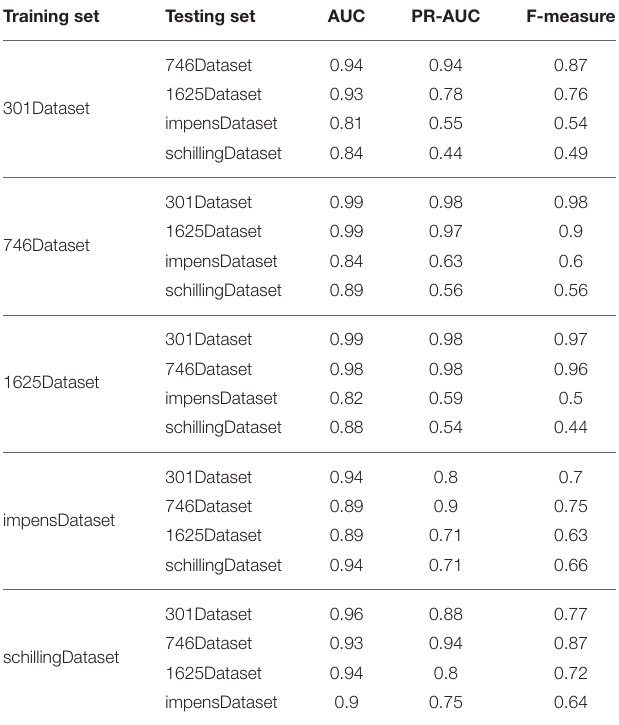
TABLE 4 | Experiment results of crossdata. Training